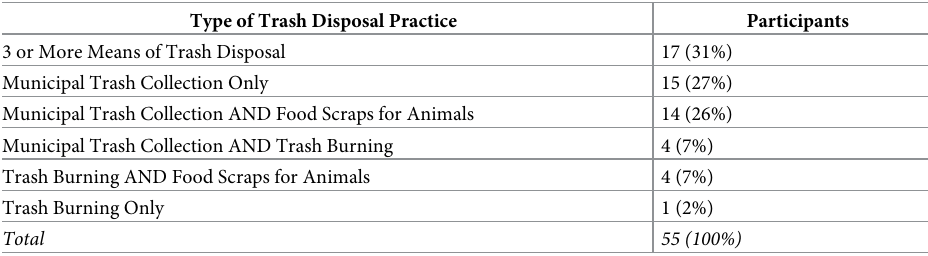
Table 2. Trash disposal practices of participants.